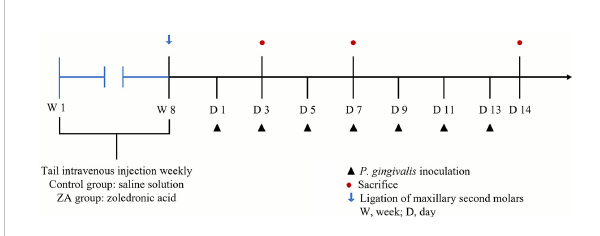
FIGURE 1 The schedule of the in-vivo experiment. Ligations around the cervixes of the maxillary second molars were set up on day 0 in both the control group (saline solution) and the ZA group (0.2 mg/ kg ZA solution). From day 1 to day 13, 12 rats in each group received P. gingivalis inoculation. The blue arrow indicates the time-point of putting ligatures around the cervixes of maxillary second molars in each group; the black triangles indicate the time-points of inoculating P. gingivalis around the cervixes of maxillary second molars in each group; the red dots indicate the time-points of randomly euthanizing 4 rats in each group.